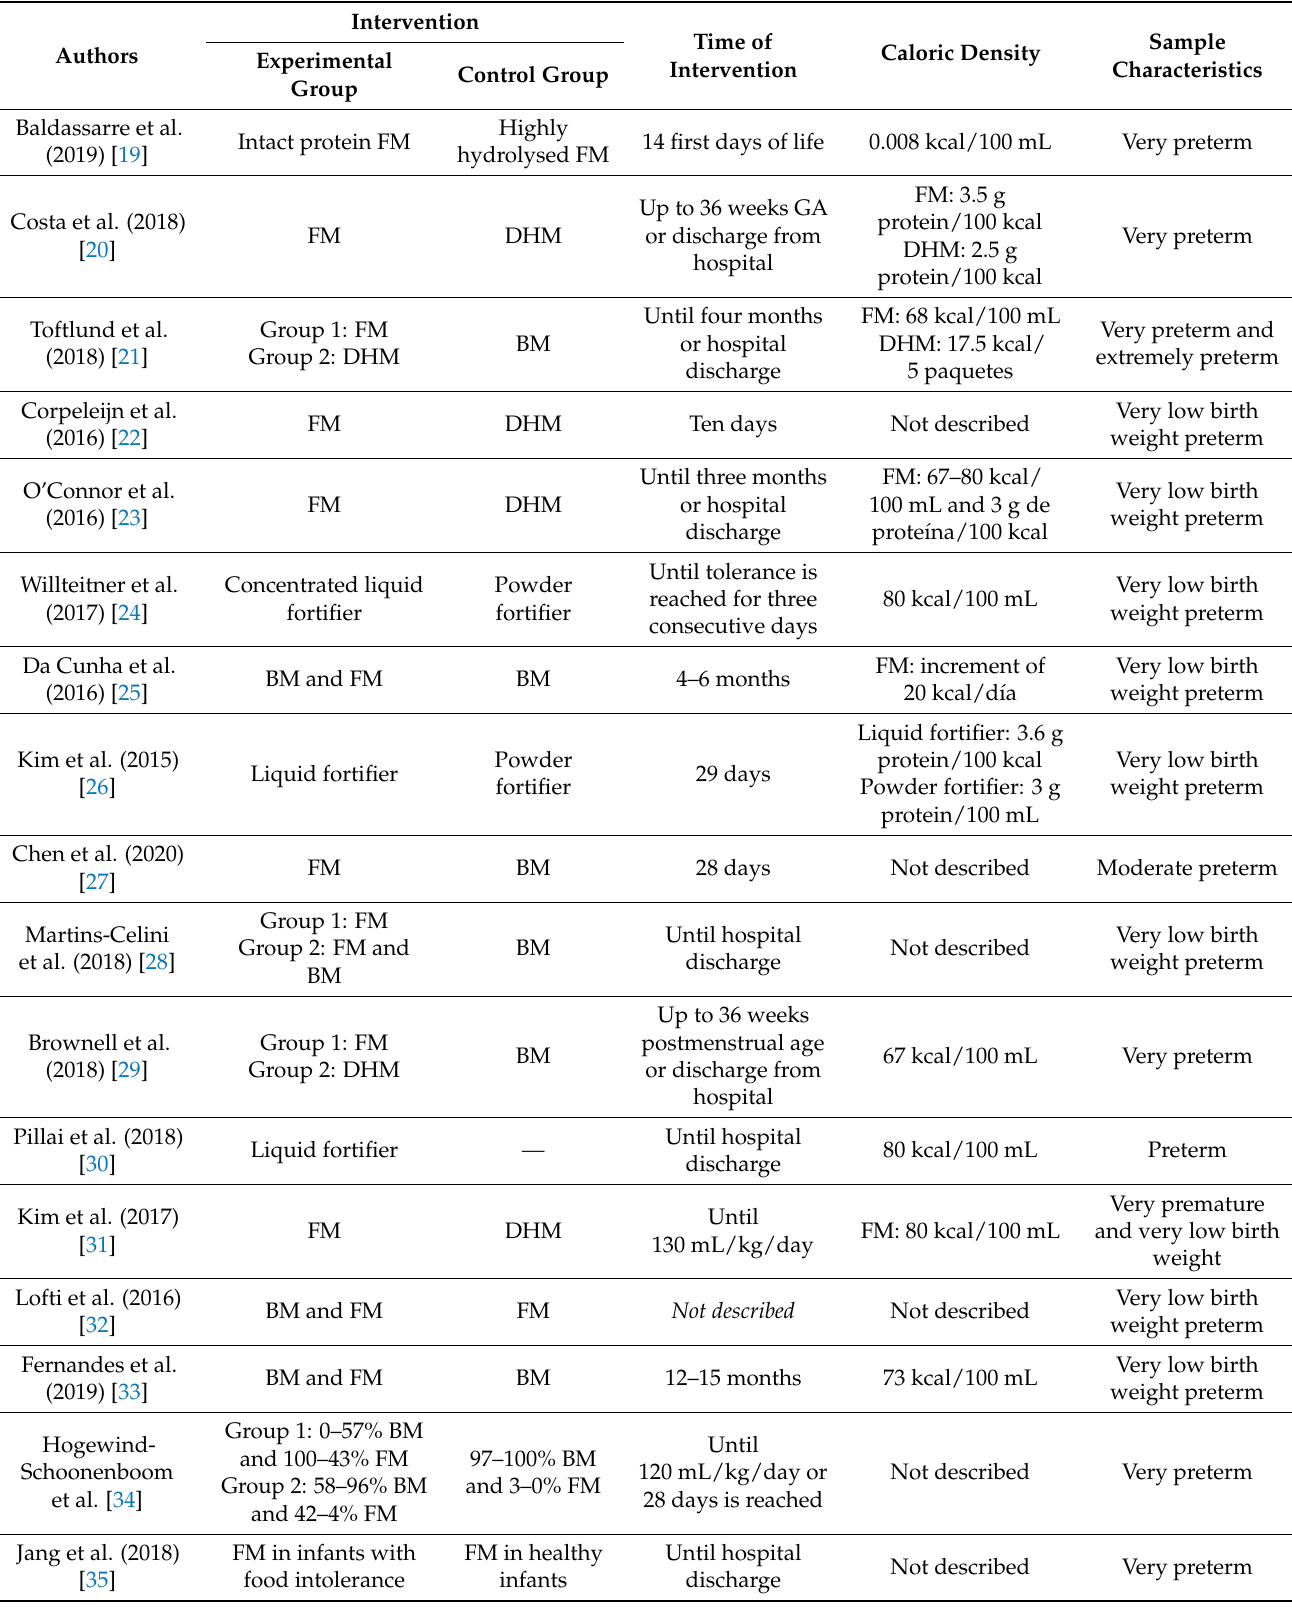
Table 2. Characteristics of the interventions of the studies